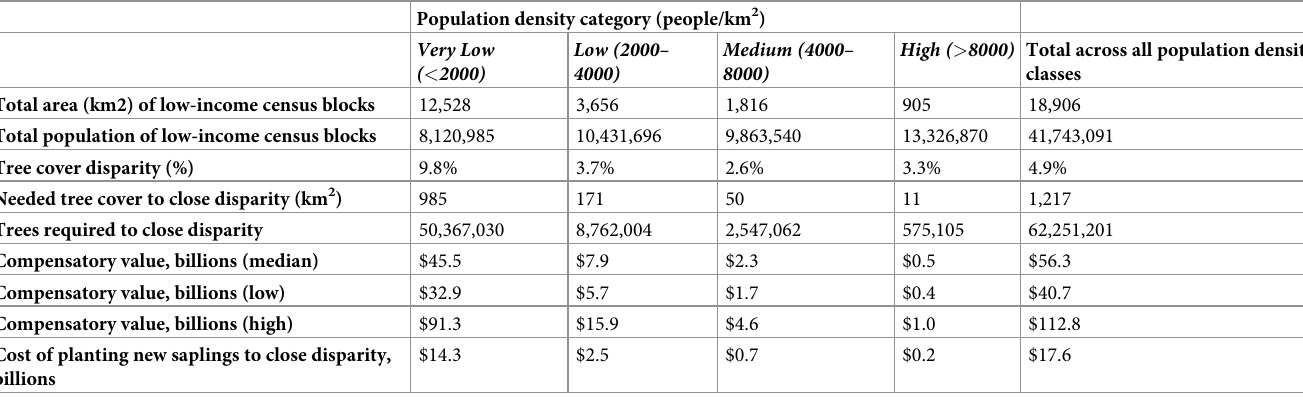
Table 2. The tree cover